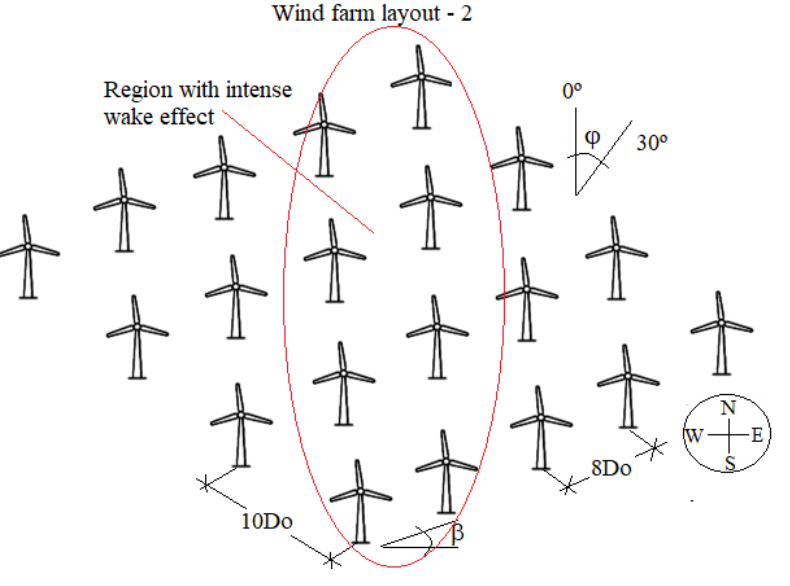
Figure 18. The region with intense wake effect in the layout 2.